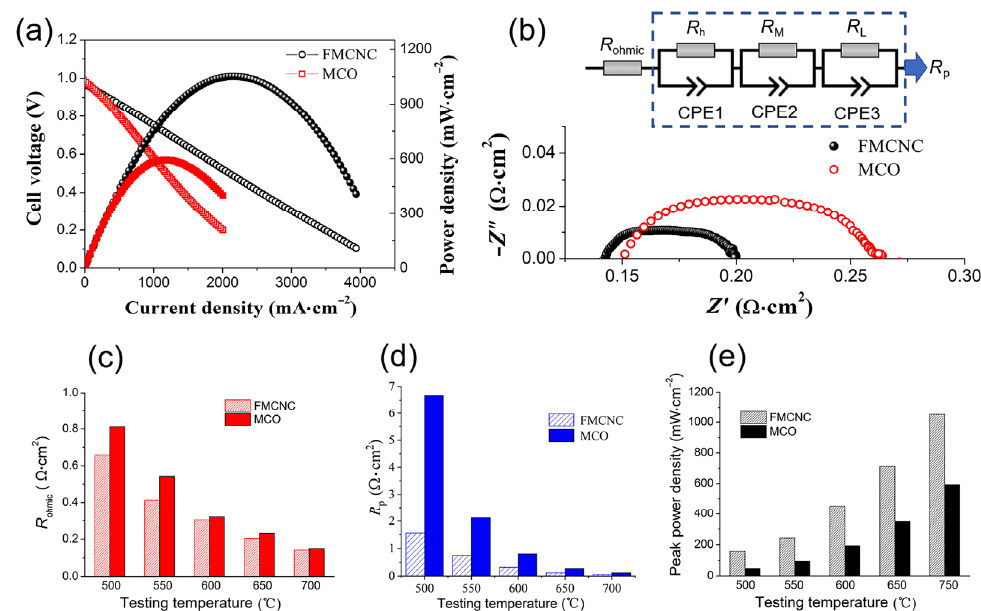
Fig. 6 Comparison of (a) fuel cell performance and (b) EIS plot for the cell using FMCNC and MCO cathodes measured at 700 , and the ℃ equivalent circuit used to fit the EIS plot is inserted; comparison of the values for (c) R ohmic , (d) R p , and (e) PPD of the cell using FMCNC and MCO cathodes tested at different